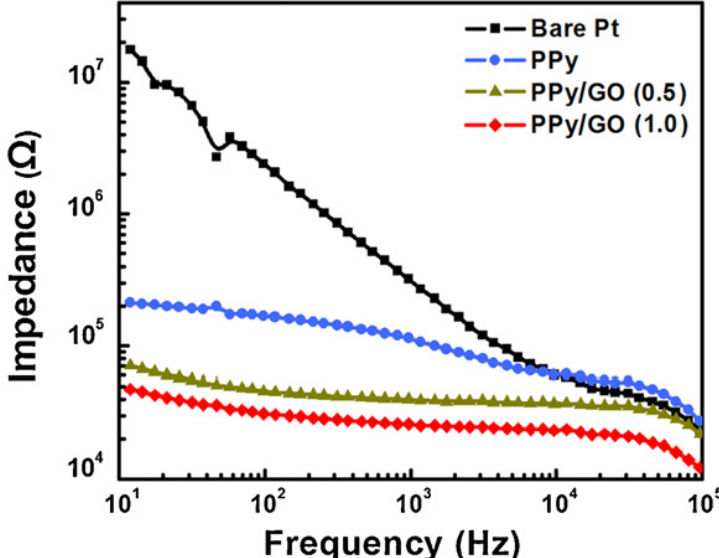
Figure 6. Electrochemical properties of Pt electrode modified with electrochemically deposited PPy, PPy/GO (0.5), and PPy/GO (1.0) coatings [82]. PPy/GO = polypyrrole/graphene oxide; Pt = platinum.